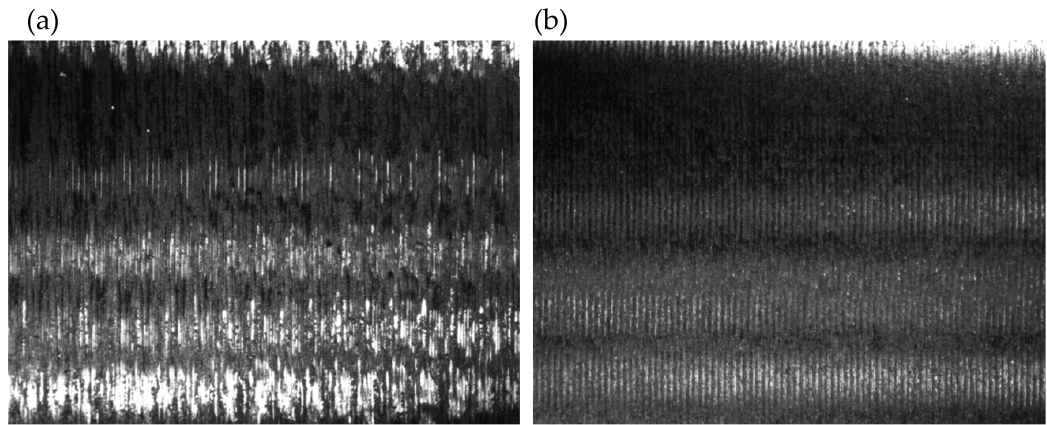
Figure 18. Surface comparison in Step 1: ( a ) without technological parameters selection support ( b ) with the support.